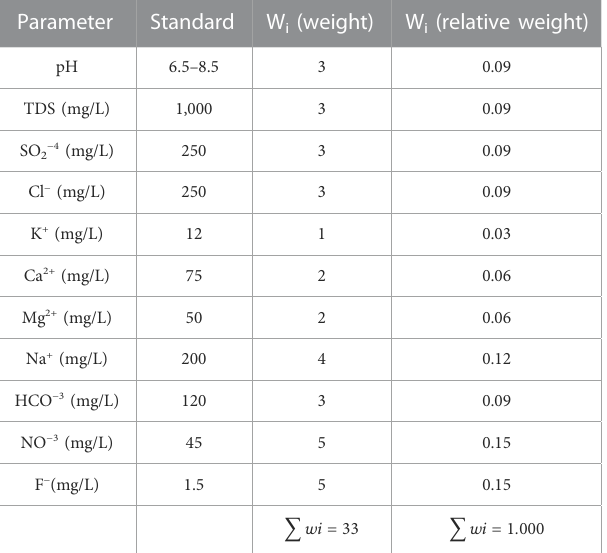
TABLE 1 Relative weight for the chosen parameters and the weight assigned.